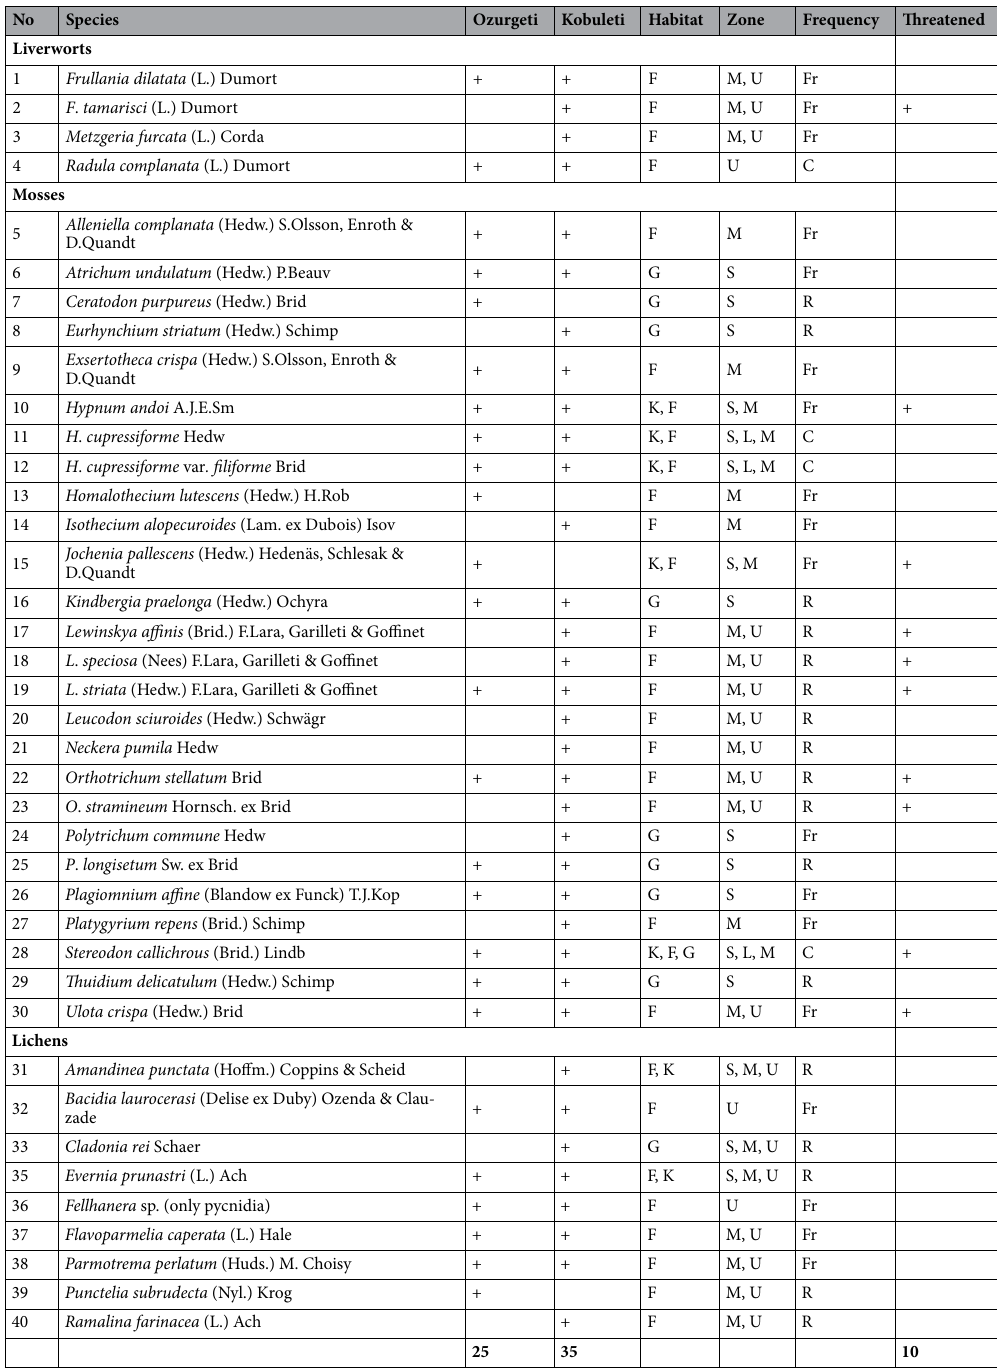
Table 1. Species recorded on individual plantations. Explanation: habitat (G—epigeic, K—epixylic, F— epiphytic); four zones on and around the tea bushes (L—lower, M—middle, U—upper zone, and S—soil); frequency of individual species (R—rare, Fr—frequent and C—common species); threatened species selected on the basis of literature cited throughout the